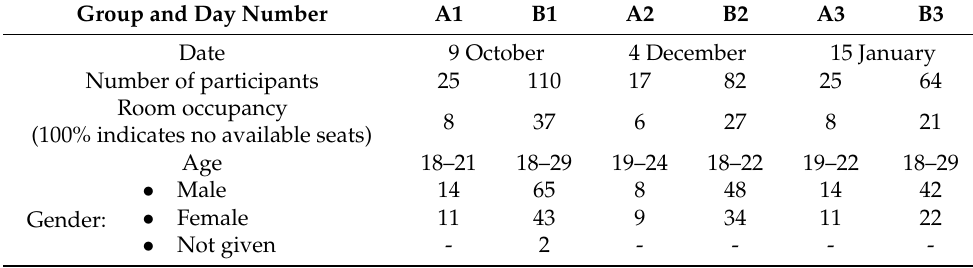
Table 2. Data on measurements and participants.